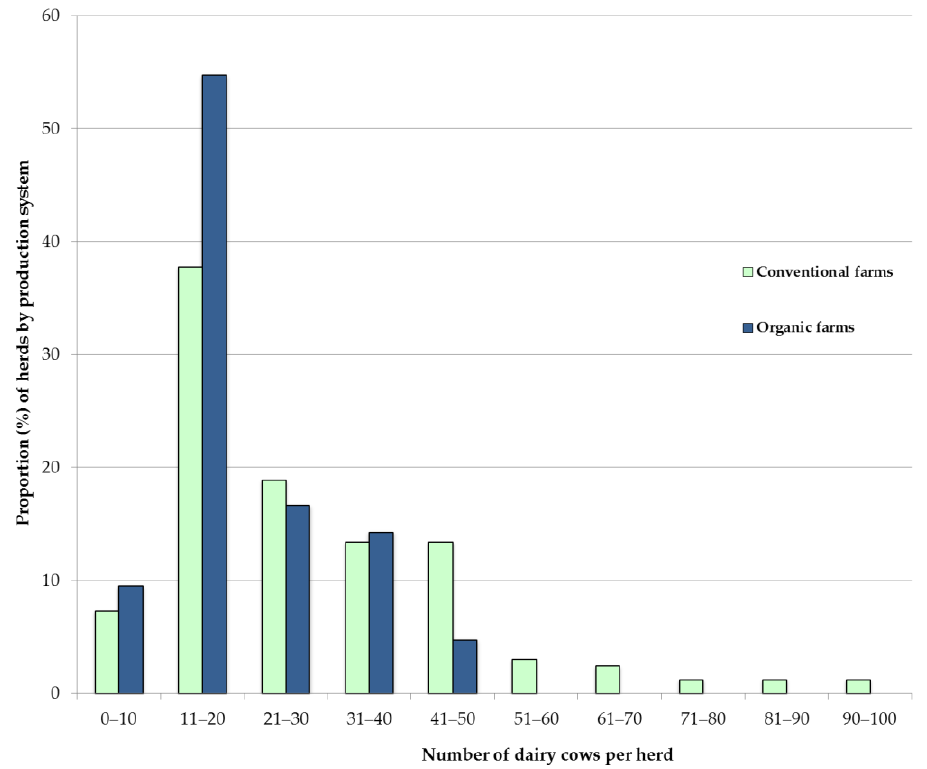
Figure 2. Herd size distribution (%) of conventional (n = 150) and organic (n = 38) farms.